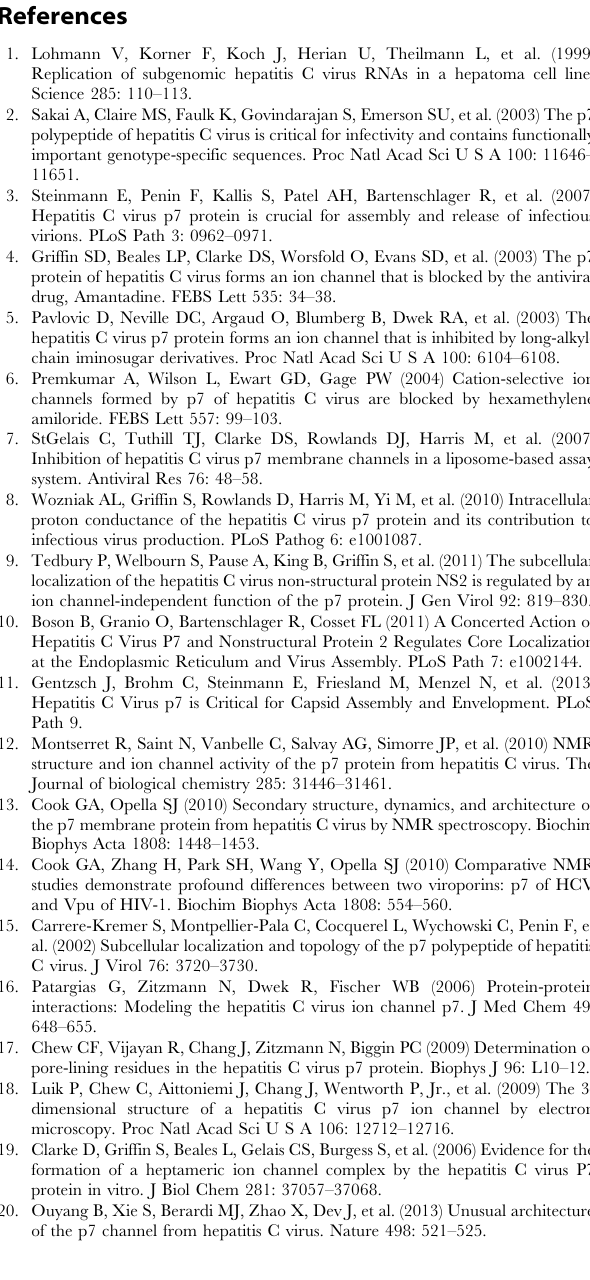
Figure S6. Average count rate versus sample fraction in flotation experiment. ( A ) extruded sample where detergent was removed before extrusion; (B) sample after addition of p7; (C) Autocorrelation function (ACF) for the samples in (A) and (B), for each of the fractions indicated on the left. The sucrose concentration is shown on the right. The calculated size of the last fraction ( # 13) in samples extruded and addition was 400 and 320 nm, respectively. For the samples in 10% sucrose (fractions # 4 to # 7), the average size was smaller, 120–150 nm in both samples (not shown). Figure S7. CF release kinetics following addition or extrusion. (A) Comparison of CF release in the addition method using melittin, p7, M2 (18-60) and only methanol. Details are indicated in the Materials and Methods section of the manuscript. Figure S8. Regions of p7 that adopt a - helical conformation according to previous reports. The stretches corresponding to a -helical regions (underlined) reported for p7 in